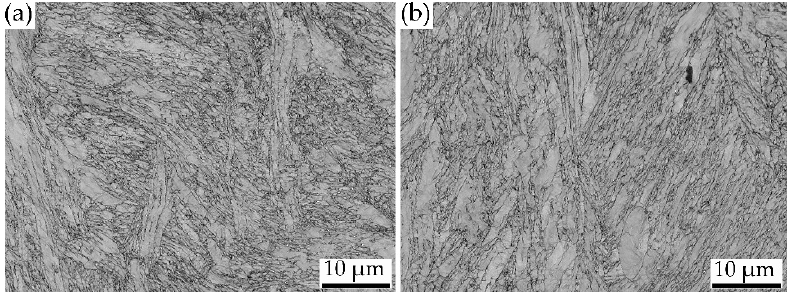
Figure 12. Band contrast and phase diagram of the necking zone at the fracture. ( a ) Once repair welding; ( b ) twice repair welding.